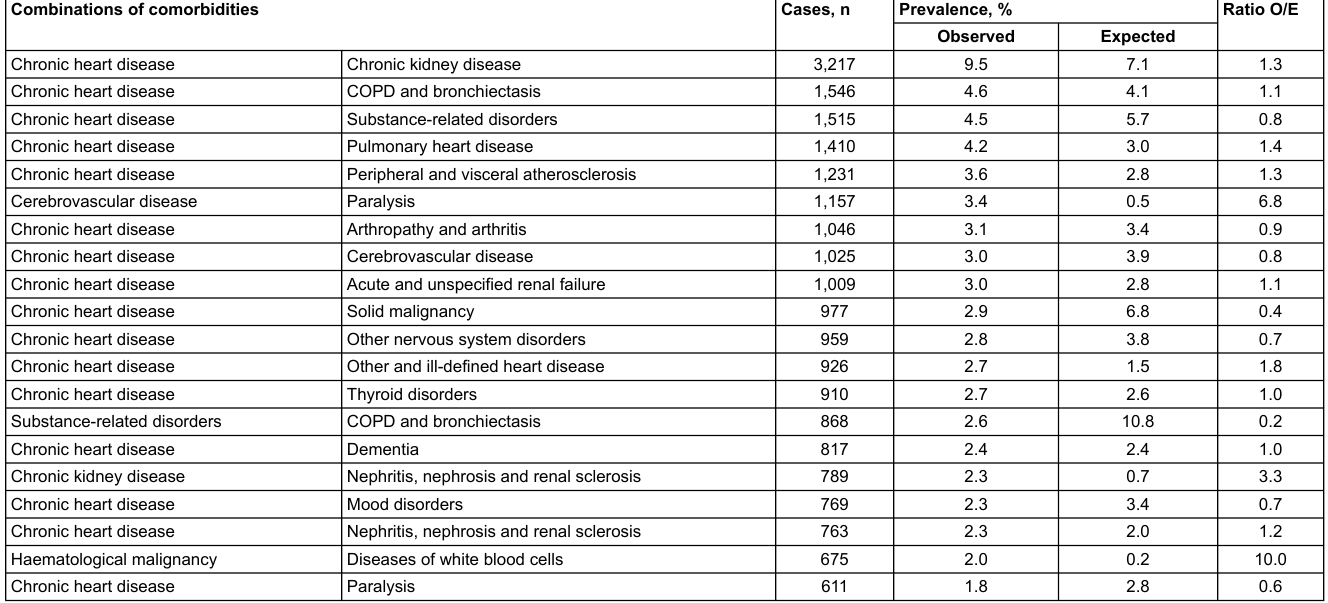
Table 2: Most prevalent combinations of comorbidities. Combinations of